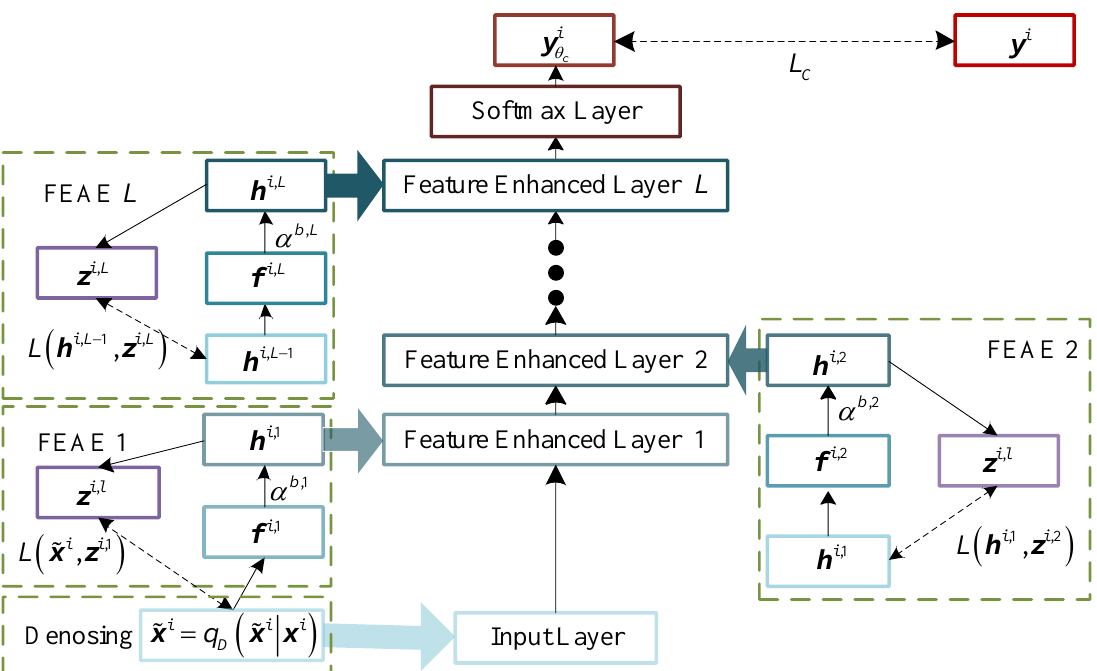
Figure 2. Structure of denoising stacked feature enhanced autoencoder with dynamic feature enhanced factor (DSFEAE-DF)